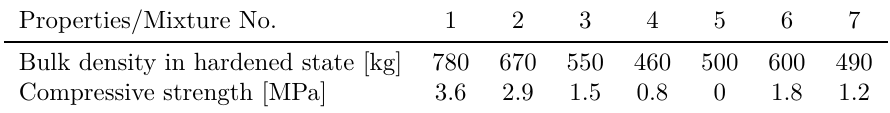
Table 3. Bulk density and Compressive strength of lightweight concrete in hardened state.